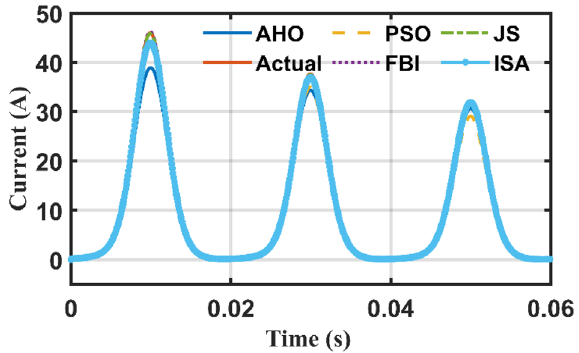
Figure 14. Inrush current behaviour using different optimizers and actual